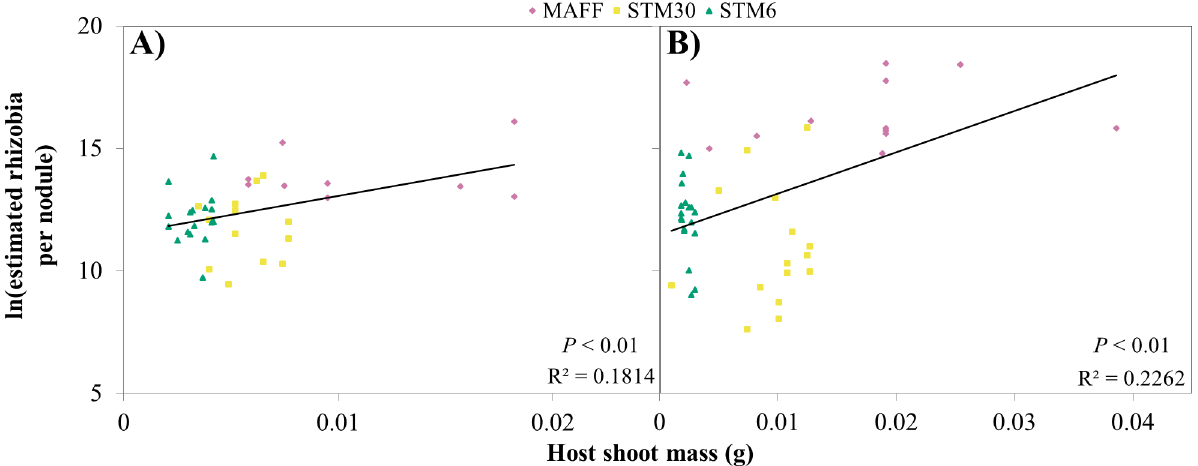
Fig 3. Sanctions are triggered continuously with nitrogen fixation. Linear regression of the natural log of estimated rhizobiaper nodule(countingCFUs of seriallydiluted extracts of crushednodules)againstthe shoot biomass of the host(dry weight) Hosts were singly inoculatedwith near-isogenic M . loti : MAFF (pink diamond), STM30 (yellow square)and STM6 (green triangle).Each symbol represents one nodule.( A) Hosts harvestedat 6wpi; F 1,38 = 8.197. ( B) Hosts harvestedat 8wpi; F 1,46 = 13.1525.